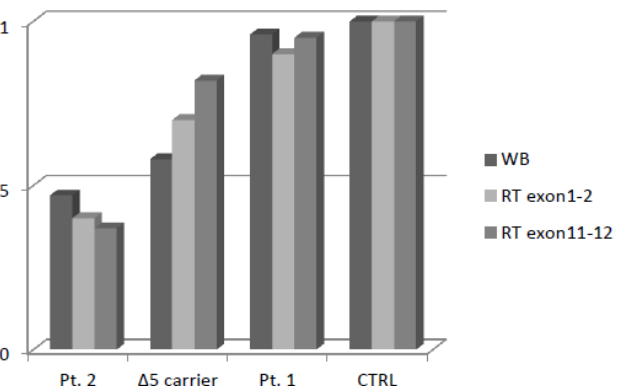
Figure 4. Densitometric analysis of NBN protein expression and mRNA Real-Time expression.